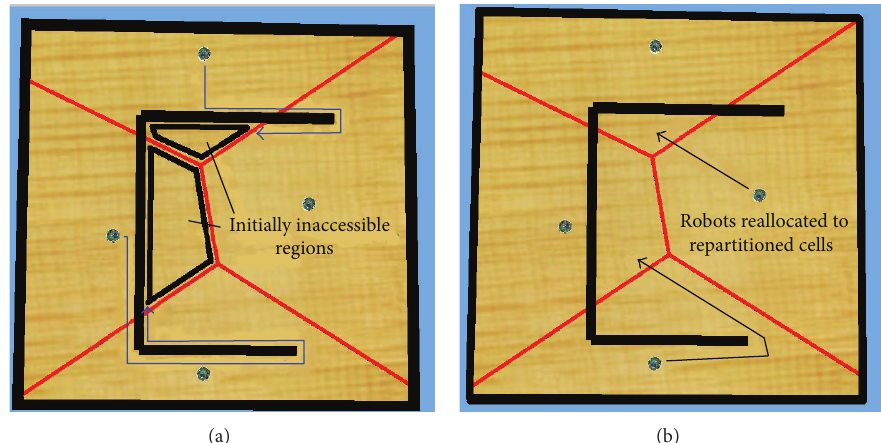
Figure 7: (a) The Voronoi cells of two robots are partially inaccessible due to obstacles. The blue solid arrows show the path taken by a robot to reach the inaccessible portions of its cell using a bug-like path planning algorithm. (b) Robots coordinate with each other to repartition the initial Voronoi cells so that each robot has a contiguous region to